Question: Identify the chart type used in this figure.
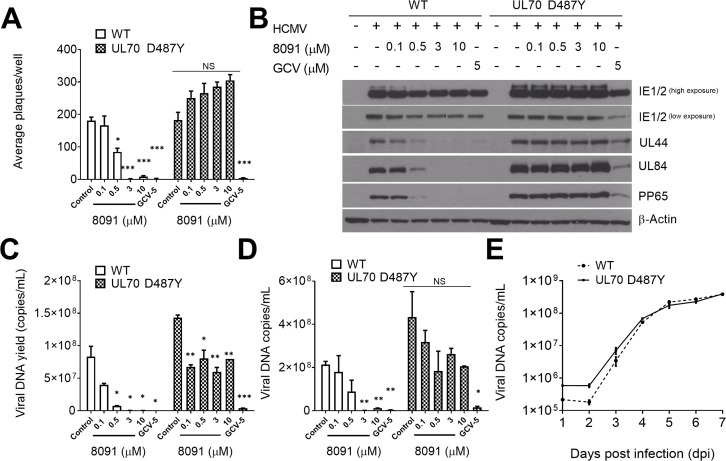
Answer: line